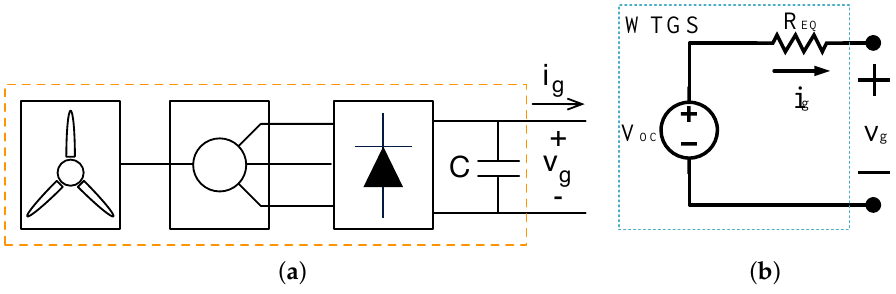
Figure 3. Wind-turbine generation system and its Thevenin equivalent. ( a ) Wind-turbine generation system. ( b ) Thevenin equivalent of the WTGS.